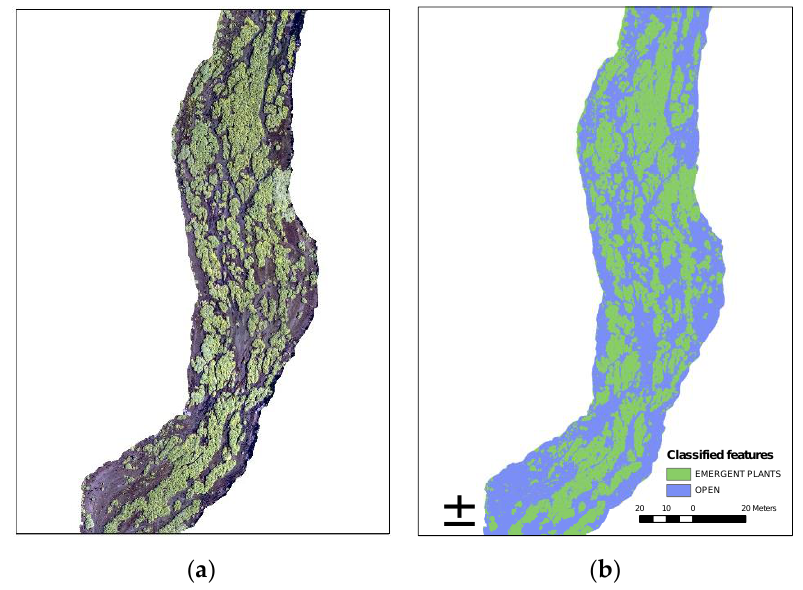
Figure 2. An example of the ( a ) orthoimagery; ( b ) results of the supervised classification, using data gathered during Survey 2 in June 2017.